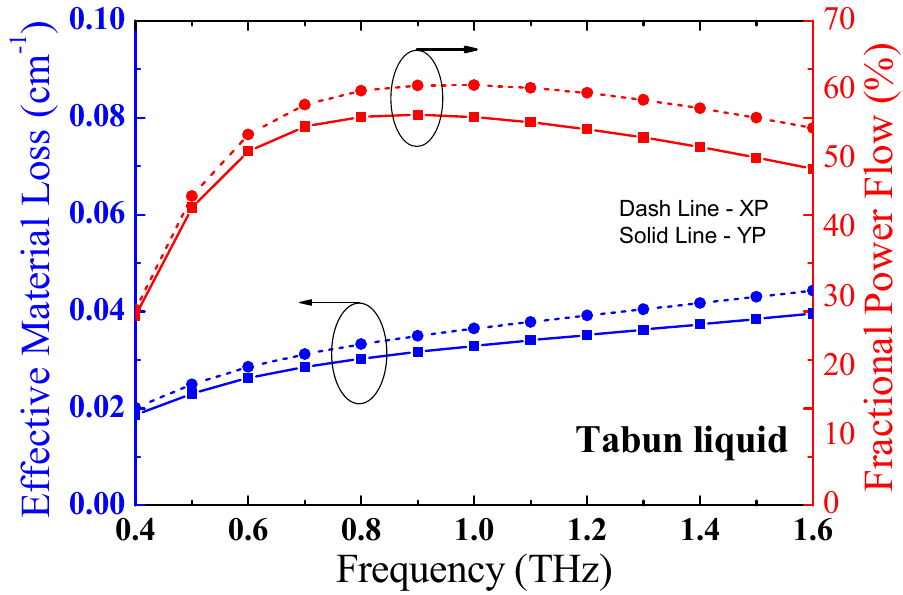
Figure 13. EML and fractional power flow of the proposed sensor when the QE air holes were filled with tabun liquid.